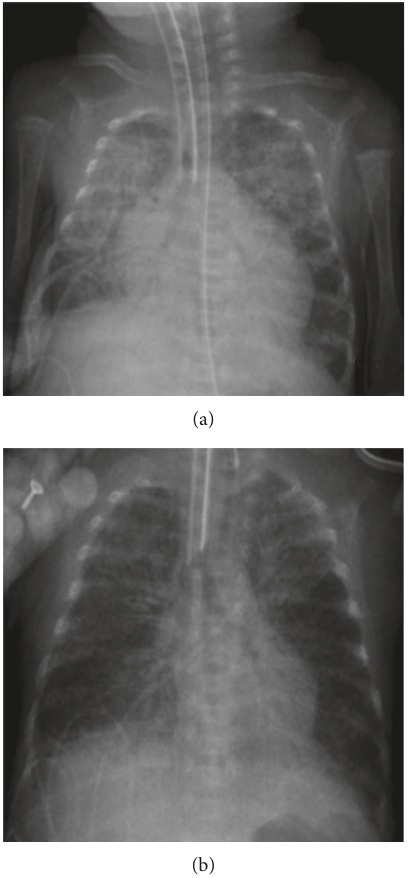
Figure 1: Acute (a) and convalescent (b) chest radiographs dem- onstrating cardiomegaly at the time of the clinical deterioration, with near complete resolution five days